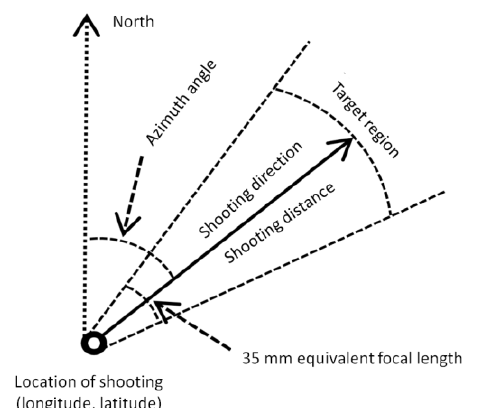
Figure 1. Schematic diagram of RSAIS geometric parameters and automatic image position matching